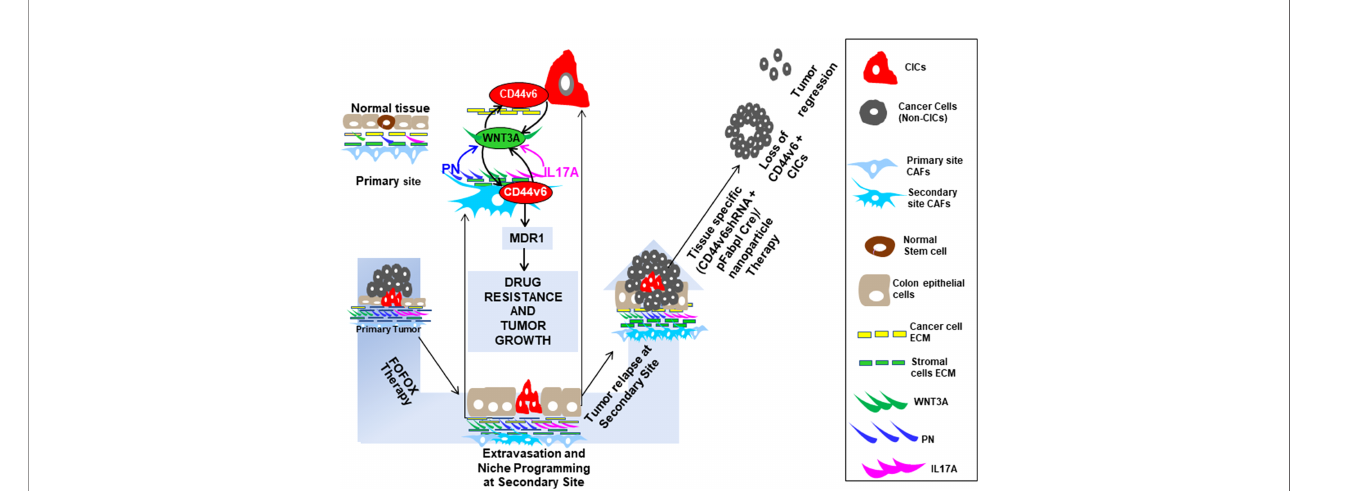
FIGURE 11 | Conclusion Figure. Colon cancer associated fi broblast derived PN and IL17A promote WNT3A induced CD44v6 expression in cancer initiating cells (CICs). CD44v6 positive CICs induce drug resistance and colorectal tumorigenesis by enhancing CD44v6/ b catenin nuclear localization and MDR1 gene expression in CICs. CD44v6 regulated PN, IL17A and WNT3A derived from chemotherapy induced CAFs that contribute to CIC maintenance through induction of the CD44v6 receptor. CD44v6 regulated PN, IL17A and WNT3A mediates the crosstalk between CICs and their niche to permit tumor growth and drug resistance. Importantly, this work identi fi es that tissue speci fi c knockdown of CD44v6 inhibits functions of CICs and their interaction with CAFs, and thereby signi fi cantly suppresses tumor